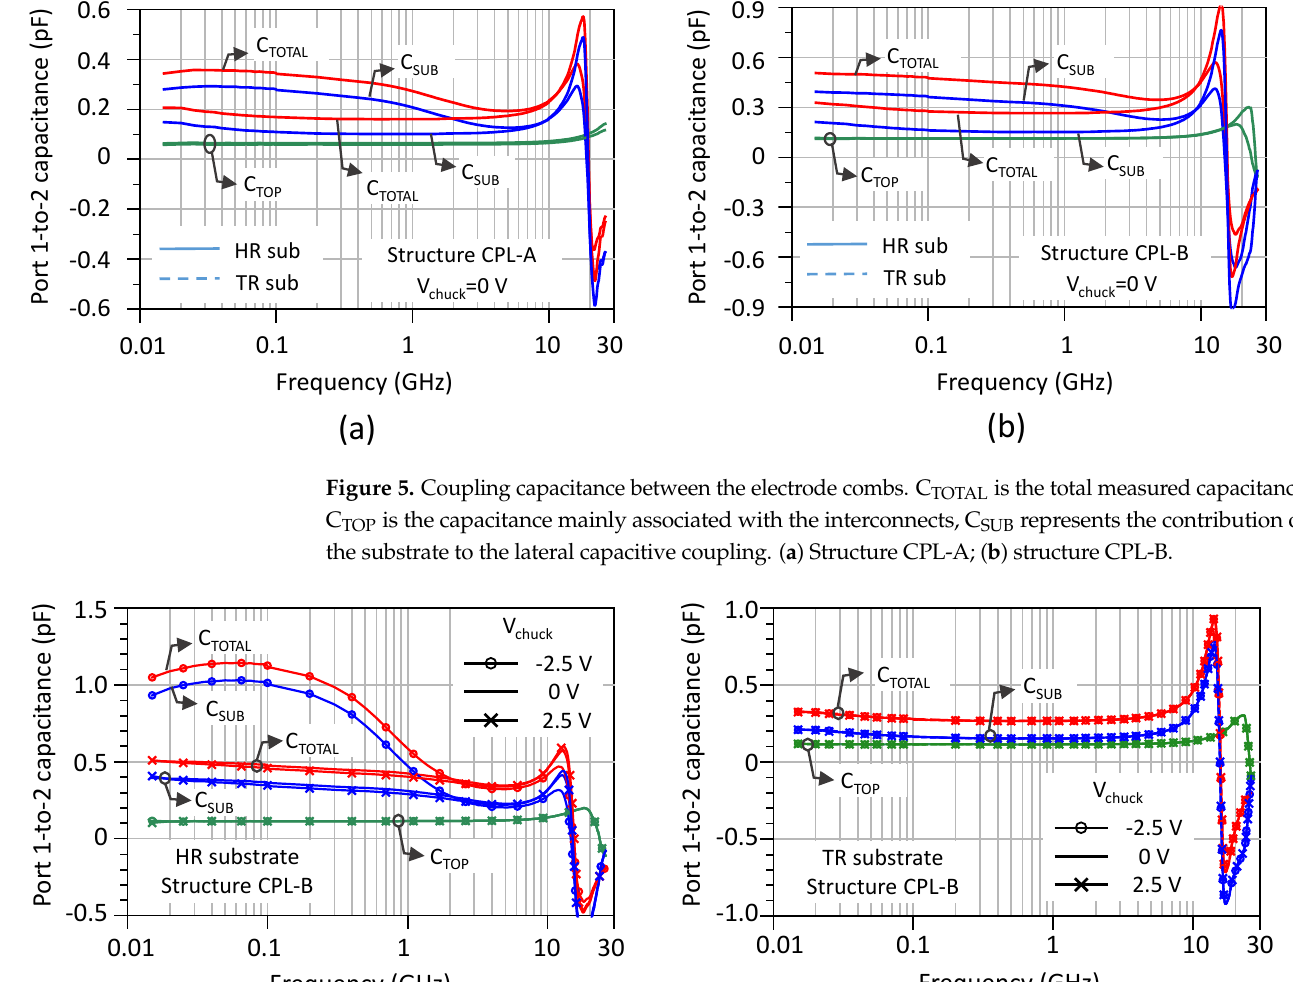
observed between 200 MHz and 2 GHz, followed by a convergence to the same values as those obtained at V SUB = 0 and 2.5 V. Figure 5. Coupling capacitance between the electrode combs. C TOTAL is the total measured capaci- tance, C TOP is the capacitance mainly associated with the interconnects, C SUB represents the contri- bution of the substrate to the lateral capacitive coupling. ( a ) Structure CPL-A; ( b ) structure CPL-B.